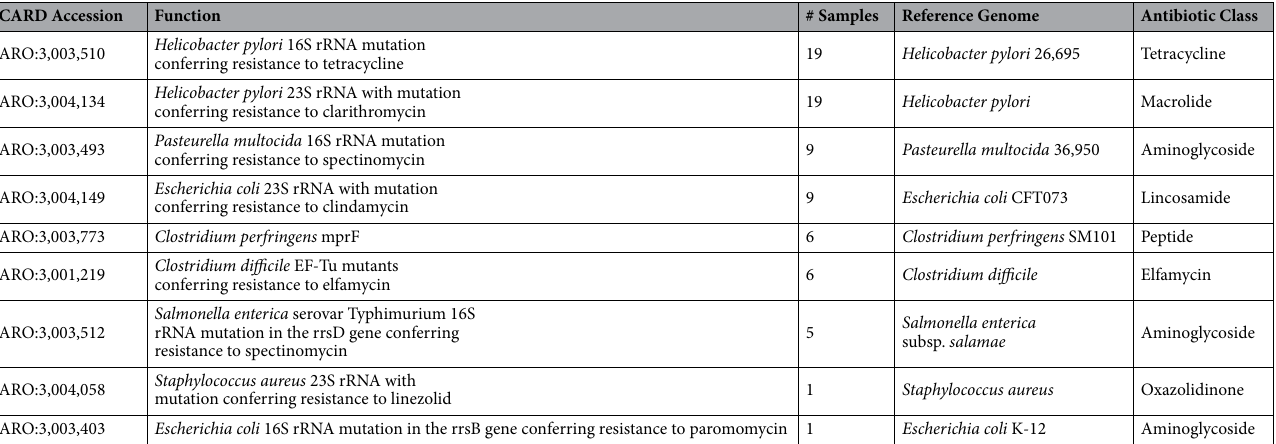
Table 1. Antibiotic resistance genes detected in Galapagos penguin